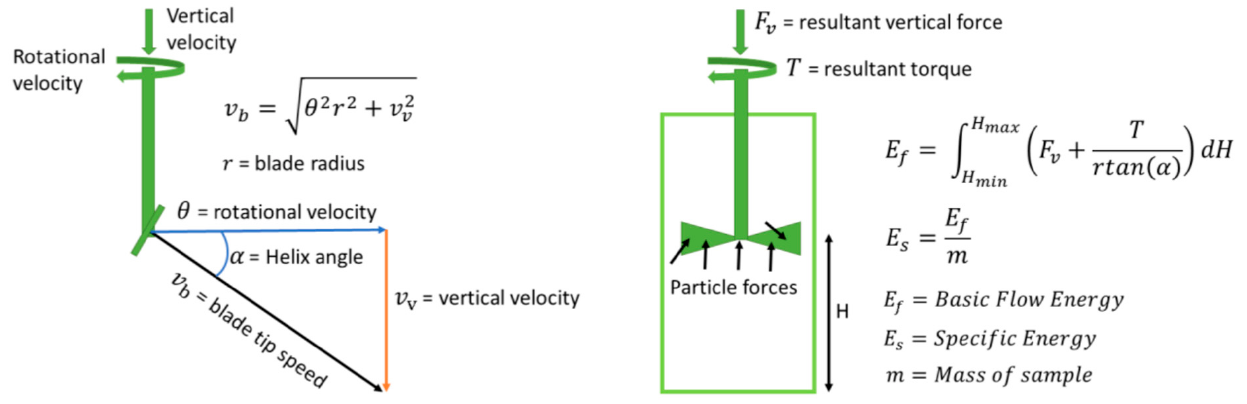
Figure 2. Schematic representation of the FT4 test used for material characterization [18].